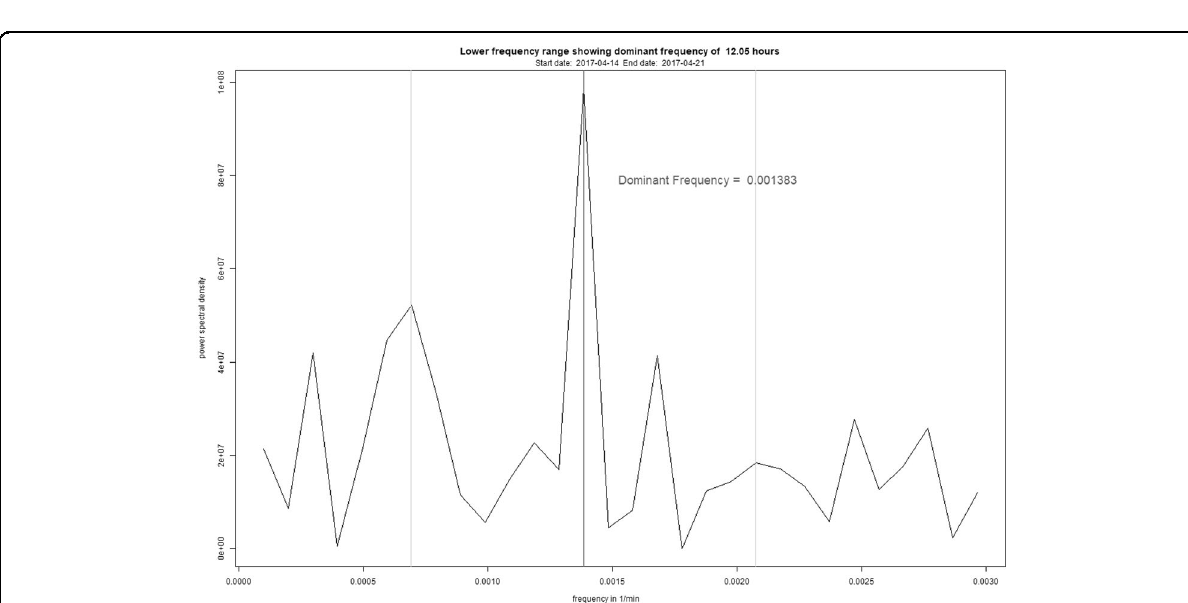
Fig. 3 Frequency spectrum of patient 11 showing the new dominant frequency (dark gray) after transitioning from a typical 24-h rhythm to an atypical 12-h rhythm. The y-axis shows the power spectrum density in U 2 while the x-axis shows the frequency in